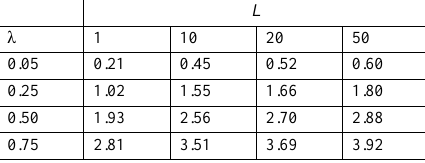
Table 1. Dictionary of the value K based on the desired parameters, λ and L of proposed chart based on ranked set sampling (RSS) scheme.